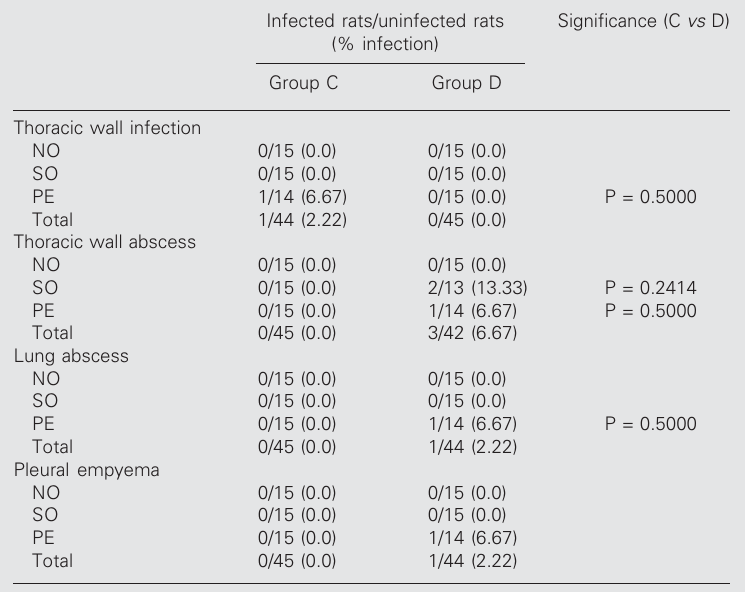
Table 1. Thoracic wall infection, thoracic wall abscess, lung abscess and pleural empyema in diabetic (group D) and nondiabetic (group C) rats. Infected rats/uninfected rats Significance (C vs D) (% infection)